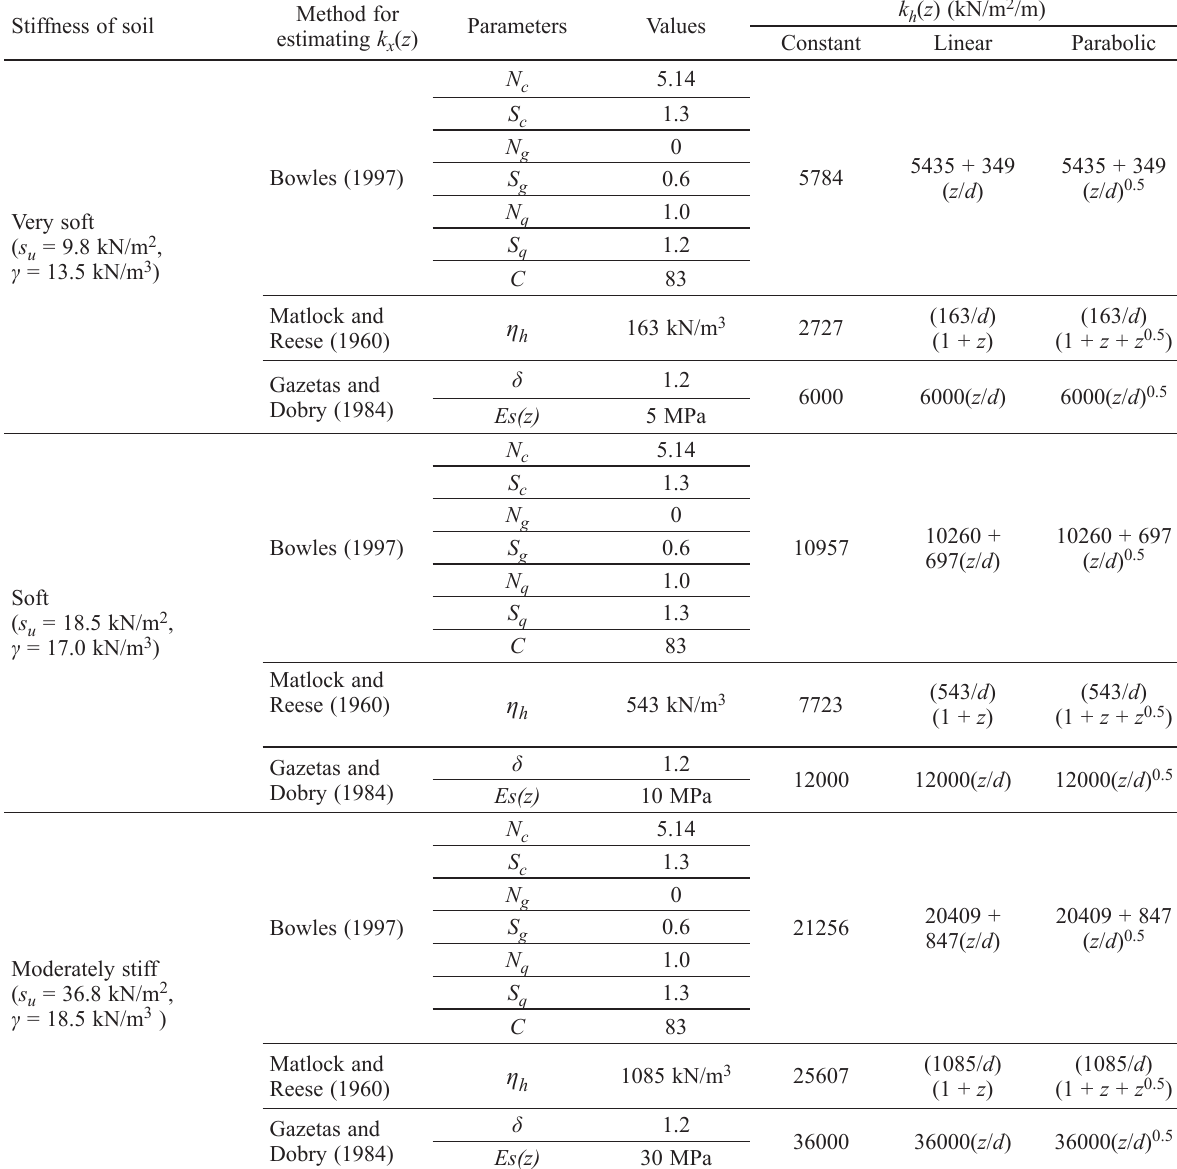
Table 2. List of various parameters to determine values of subgrade modulus Method for Stiffness of soil estimating k x ( z